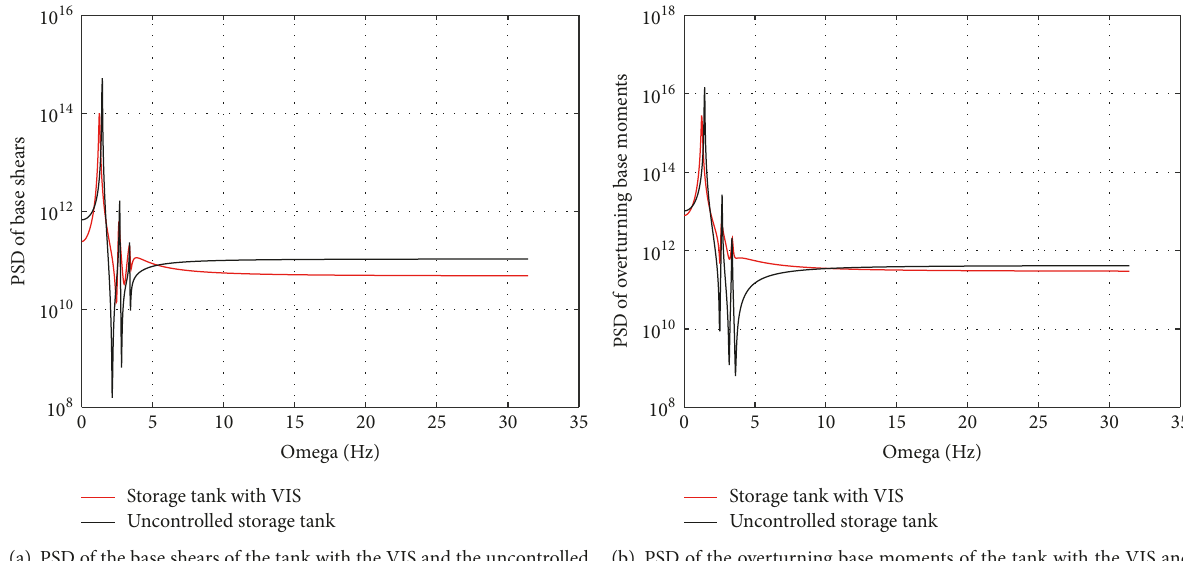
Figure 6: Power spectral density (PSD) curves of the benchmark tank ( 𝜇 𝑐 = 0.5 , 𝜇 𝑚 = 0.5 , and 𝑠 = 1.5 ) and the uncontrolled tank.